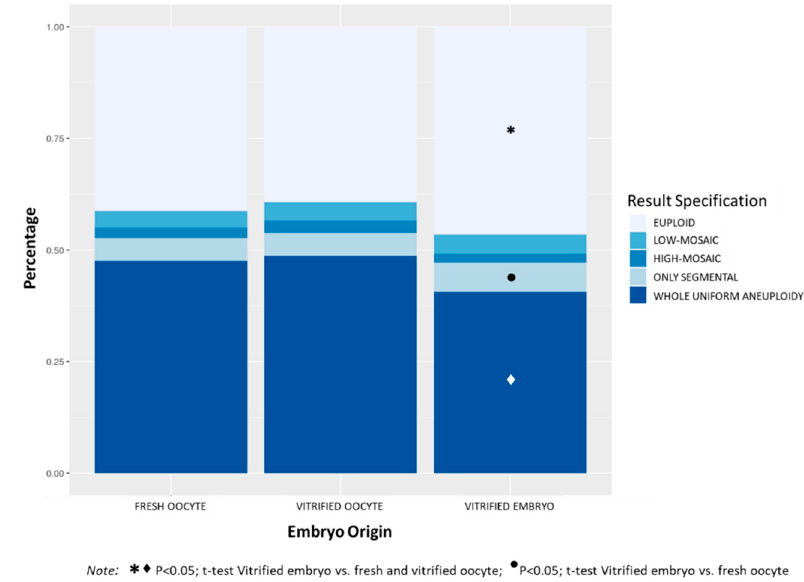
Figure 4. Distribution of the percentages of chromosomal abnormalities in TE biopsies (euploid, low-mosaic, high-mosaic, only segmental, and whole uniform aneuploidy) according to the embryo origin (fresh oocyte, vitrified oocyte, and vitrified embryo). The mean number of embryos biopsied (SD) per case was 4.8 (3.3) for fresh oocyte category, 4.7 (3.4) for vitrified oocyte and 4.5 (3.5) for vitrified embryo category.